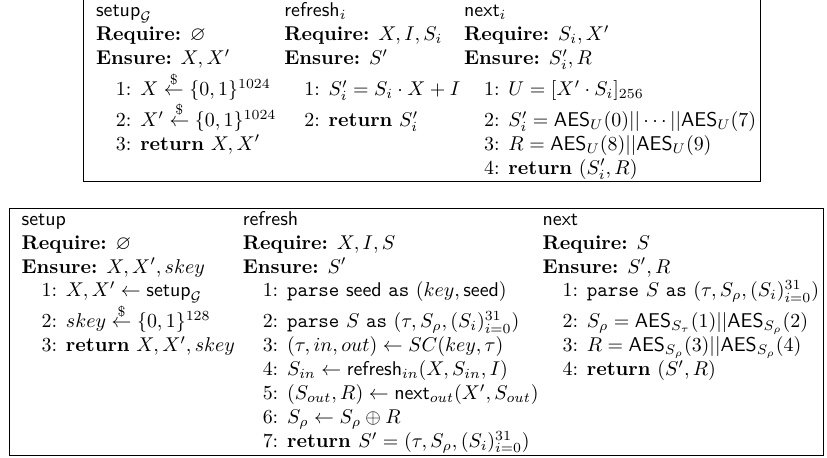
Figure 22: NROB : A Secure Construction ( G i , G )